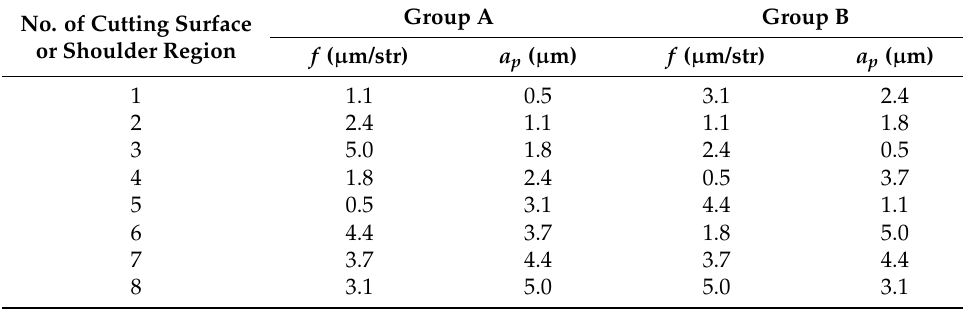
Table 2. Groups A and B of cutting parameters ( f : feed; a p : cutting depth).